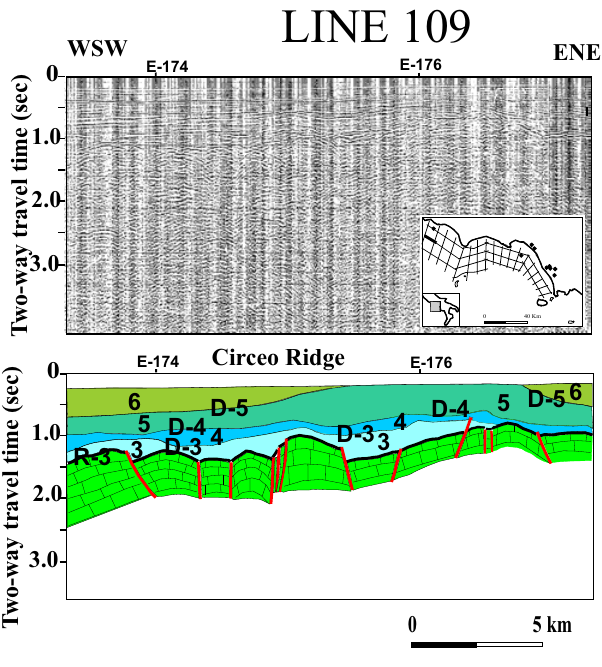
Figure 12. Seismic profile E109 (re-interpreted after Aiello et al. [2000]), showing the structural high of the Circeo ridge. Note that the structural high is intensively affected by normal faulting. Key: Regional unconformities: R-3, D-3, D-4, D-5. Seismic units: 3, 4, 5,